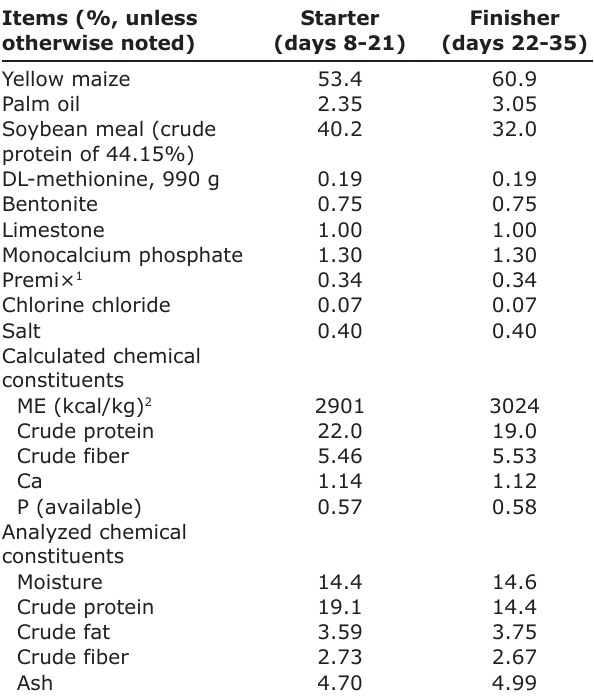
Table-1: Ingredients and chemical constituents of feed (days 8-35). Items (%, unless otherwise